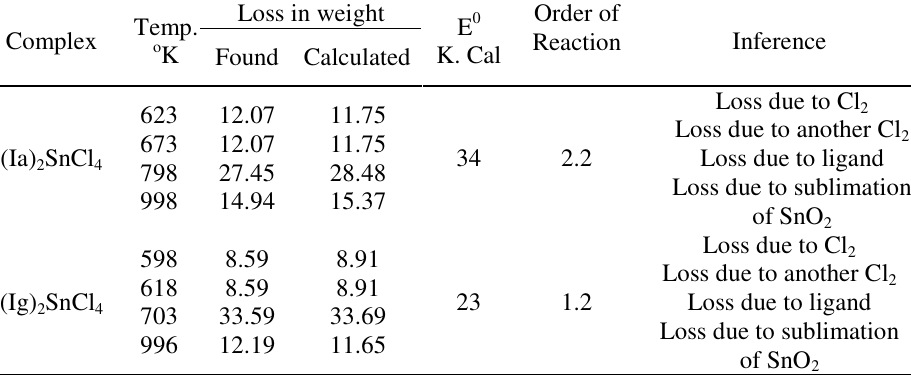
Table 6. Thermo gravimetric data of